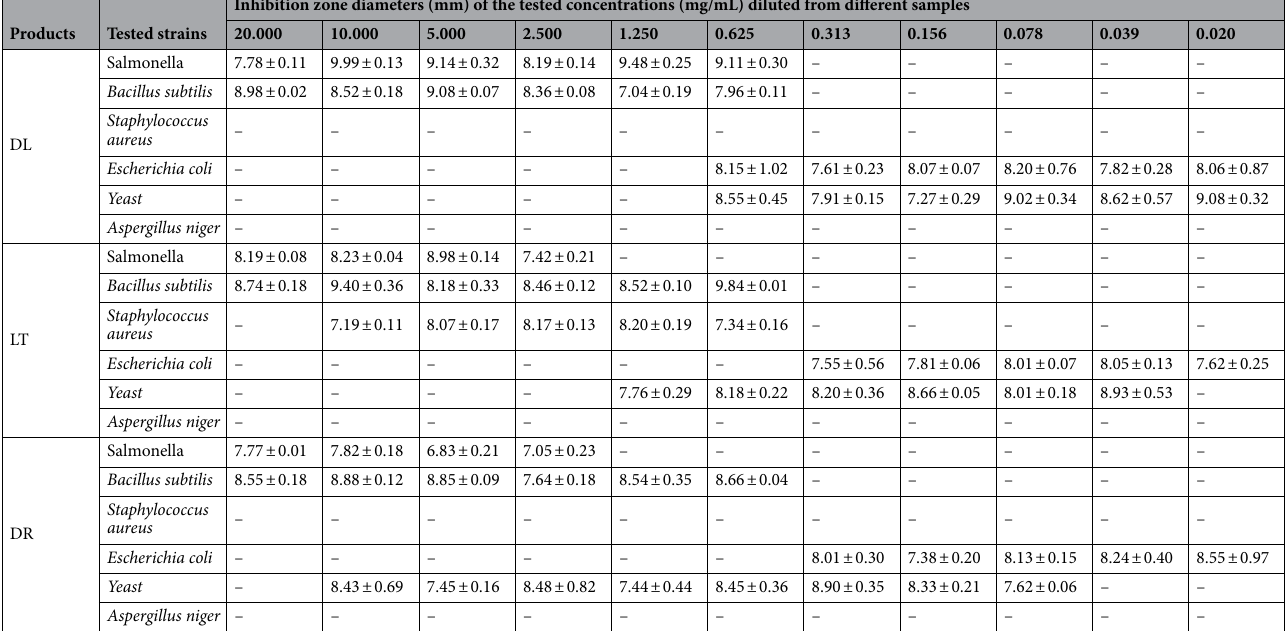
Table 5. Zone diameters of antimicrobial inhibition to six testing microbial strains at different concentrations of three products from Astragalus membranaceus (Fisch.) Bge. Each data indicates mean ± SD. “–” indicates no inhibition detected in the test. DL, dry leaves; LT, leaf tea; DR, dry roots.